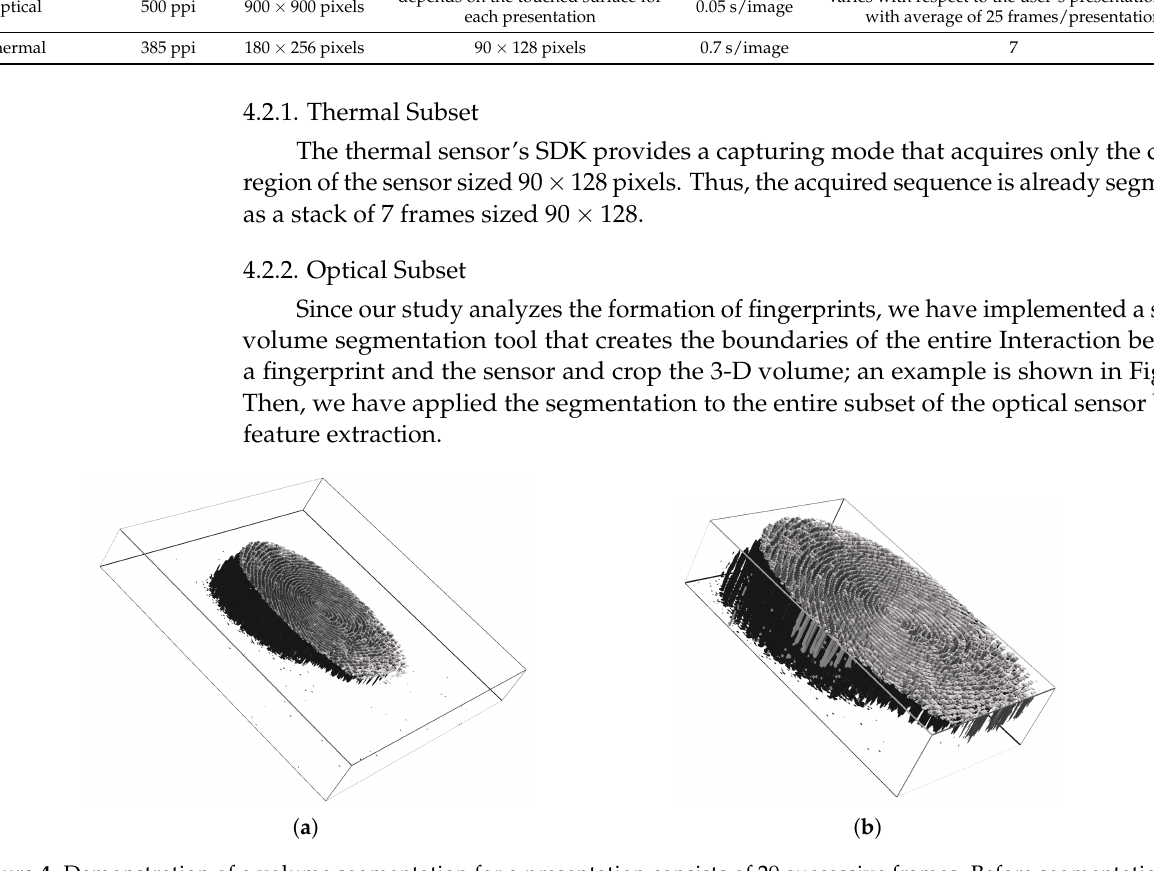
Figure 4. Demonstration of a volume segmentation for a presentation consists of 29 successive frames. Before segmentation sized 375 × 400 ( a ), and after segmentation 234 × 145 ( b ). The figures do not reflect the real scale of the